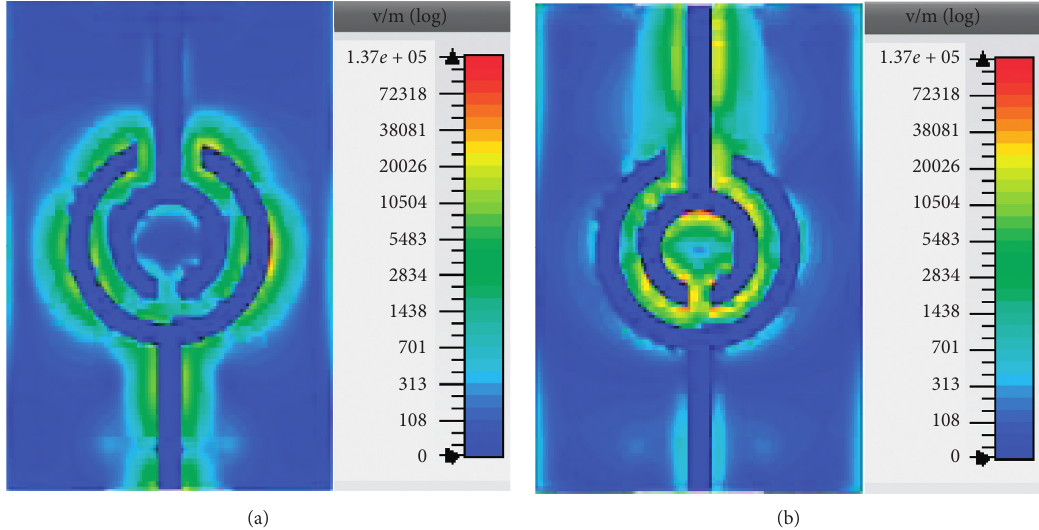
Figure 7: Electric field distribution at 30GHz due to (a) Port 1 and (b) Port